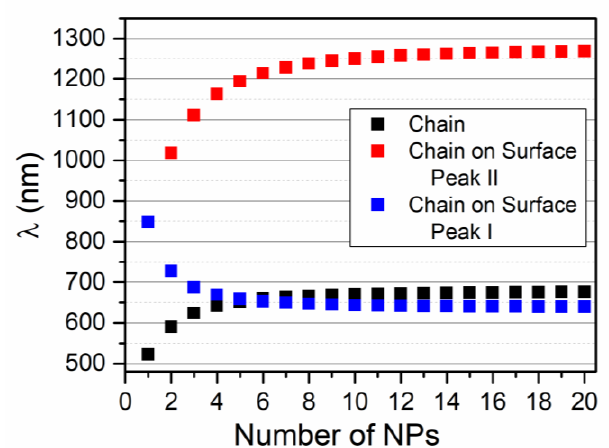
Figure 10. The lowest and highest energy bright mode of the chain on the surface (white square) and the chain (black square) as a function of the number of NPs in the chain. Values of ω 0 and β taken from Reference [22] and the value of α = − 2.6 eV.